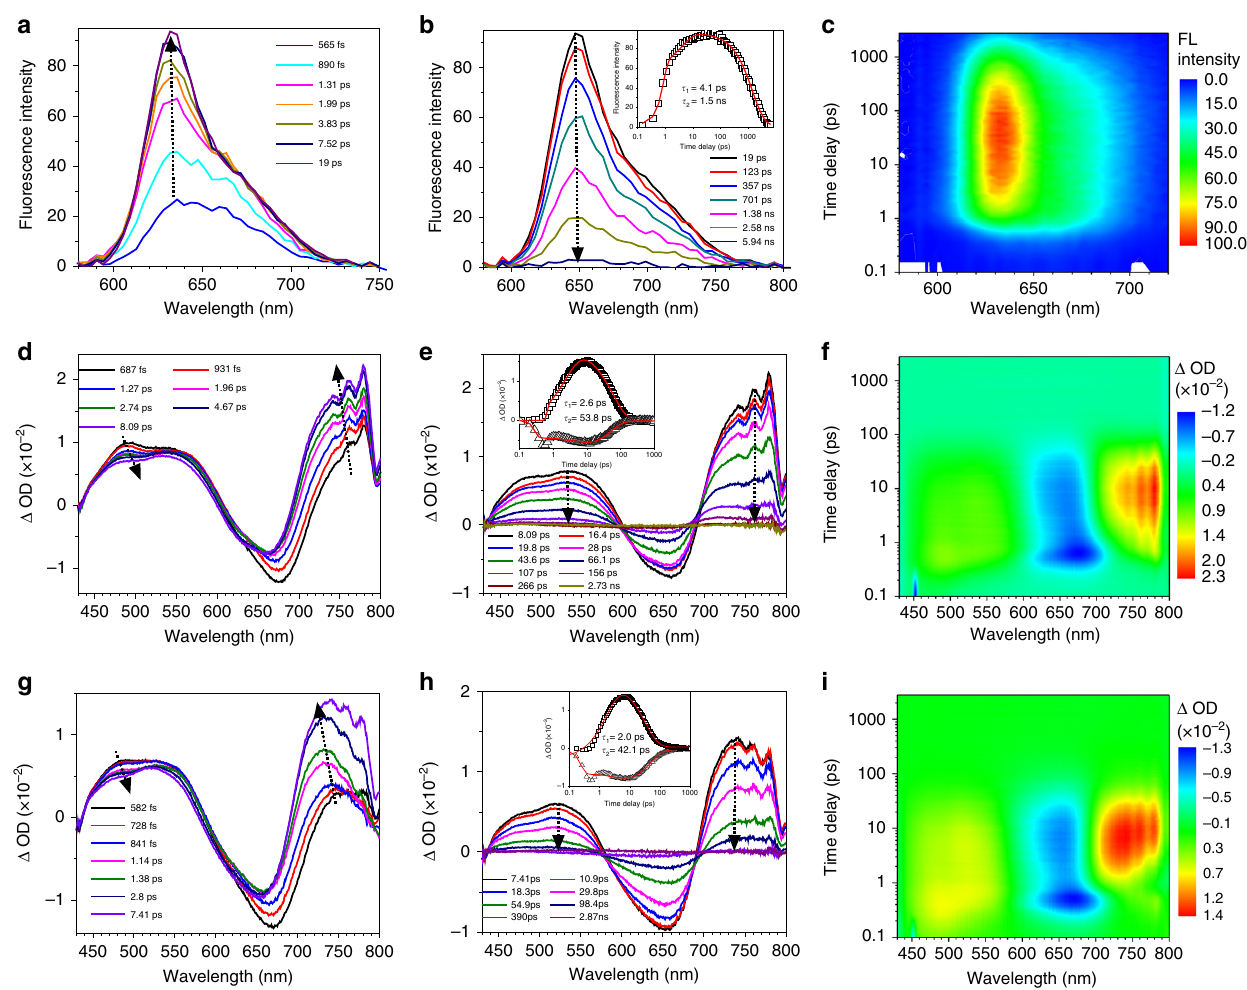
Fig. 2 Excited-state dynamics of NDTA, 2TPE-NDTA, and 2TPE-2NDTA in solution observed by ultrafast time-resolved spectroscopy. a , b The fs-TRF spectra of NDTA obtained at time delay from 565 fs to 5.9 ns in THF after 400nm excitation. Kinetic traces at 630 nm (black square) and solid lines (red) indicate the fi tting trace to the experimental data points. d , e The fs-TA spectra of 2TPE-NDTA obtained at different time delays after 400 nm excitation. Kinetic traces at 730 nm (black square) and 630 nm (black triangle), solid lines (red) indicate the fi tting trace to the experimental data points and the respective fi t based on a global analysis with two exponential functions. g , h The fs-TA spectra of 2TPE-2NDTA at different time delays acquired after excitation at 400 nm. Kinetic traces at 726 nm (black square) and 629 nm (black triangle) and solid lines (red) indicate the fi tting trace to the experimental data points and the respective fi t based on a global analysis with two exponential functions. c , f , i Three-dimensional femtosecond transient emission and absorption spectra of NDYA2 ( c ), 2TPE-NDTA ( f ), and 2TPE-2NDTA ( i ). FL fl uorescence, Δ OD = log I 100 I , I 100 the light level measured through T ð t ; λ Þ the sample before excited states are created, I T transmitted (probe) light through the